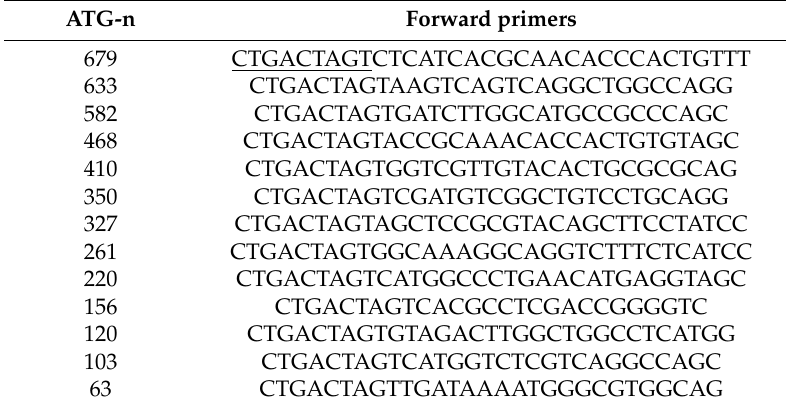
Table 1. Primers for BamH1-A rightward frame-1 (BARF1) promotor reporter vector. Forward primers used to construct deletion mutants of the BARF1 promoter luciferase reporter vector starting 679 nucleotides upstream the ATG start site. Underlined: SpeI restriction site.